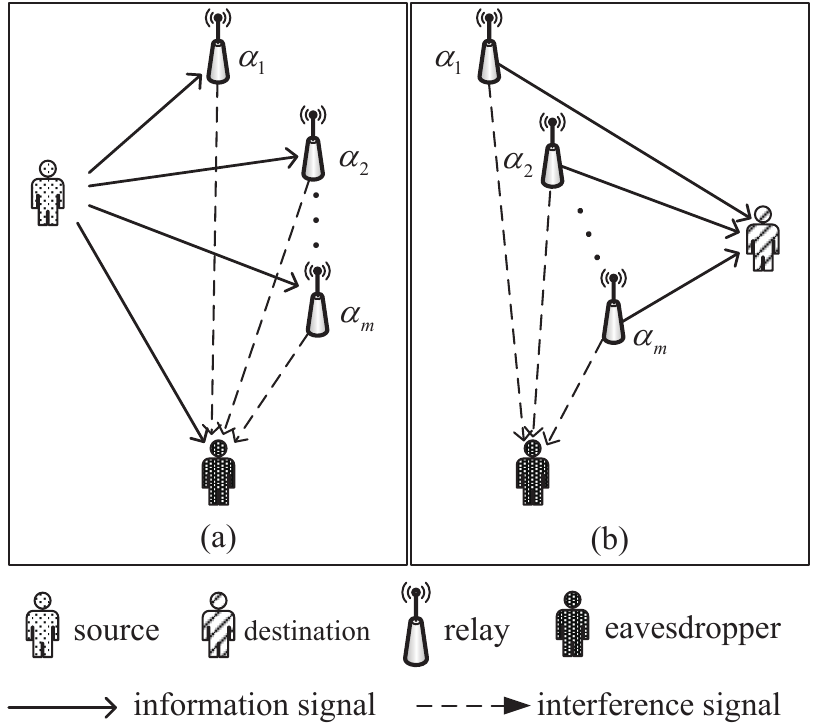
Figure 1. Secure relay selection system model: ( a ) first time slot; ( b ) second time slot.